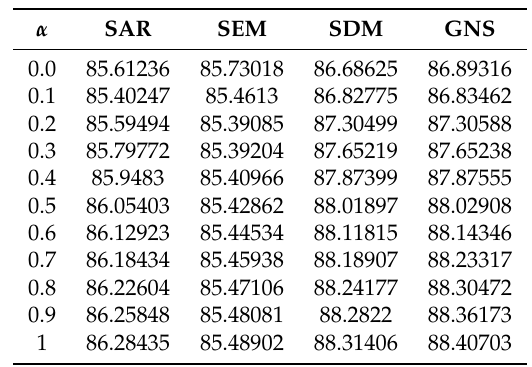
Table 7. Log likelihood for conditional β -convergence models for 2010–2014. The weight matrix is